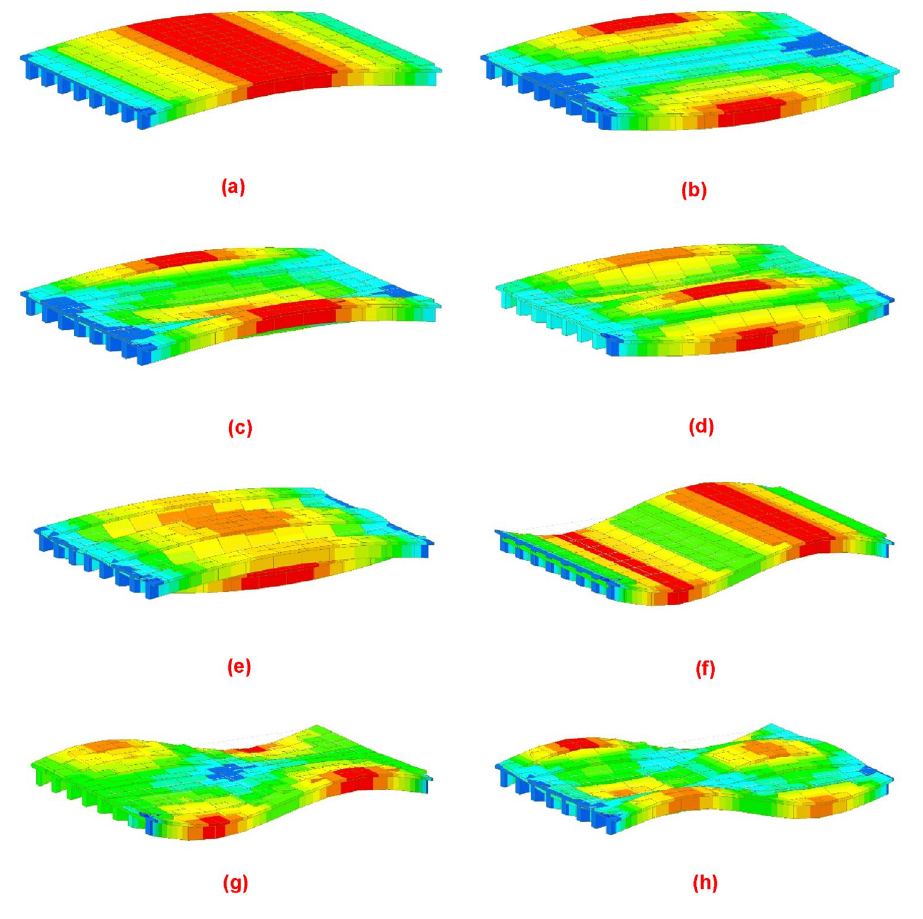
Figure 17. Modal analysis using a traditional grillage calculation model: ( a ) eigenmode function 1; ( b ) eigenmode function 2; ( c ) eigenmode function 3; ( d ) eigenmode function 4; ( e ) eigenmode function 5; ( f ) eigenmode function 6; ( g ) eigenmode function 7; ( h ) eigenmode function 8.